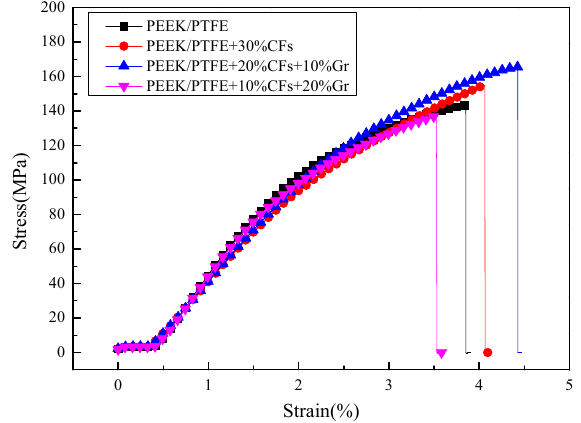
Figure 1. The stress-strain curves of four different PEEK/PTFE composites.